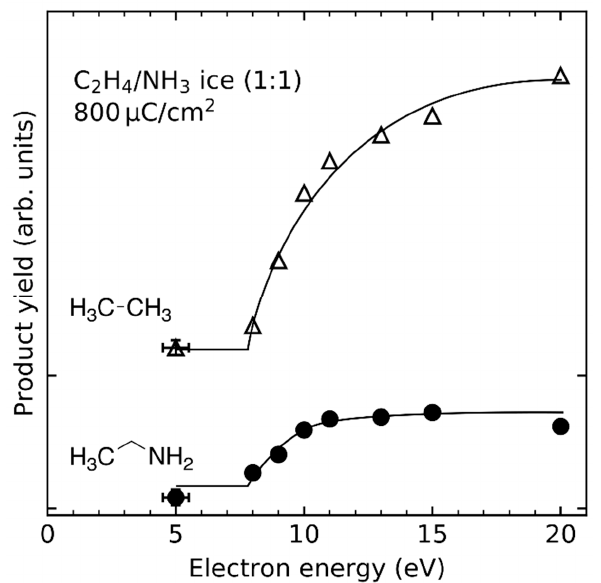
Figure 16. Dependence of the relative product yields of ethane (C 2 H 6 ) and ethylamine (C 2 H 5 NH 2 ) on electron energy obtained by TDS after irradiation of a C 2 H 4 /NH 3 (1:1) mixed ices with 800 µ C/cm 2 . The solid lines serve as a guide to the eye. Adapted with permission from Ref. [29]. Copyright 2014 American Chemical Society.